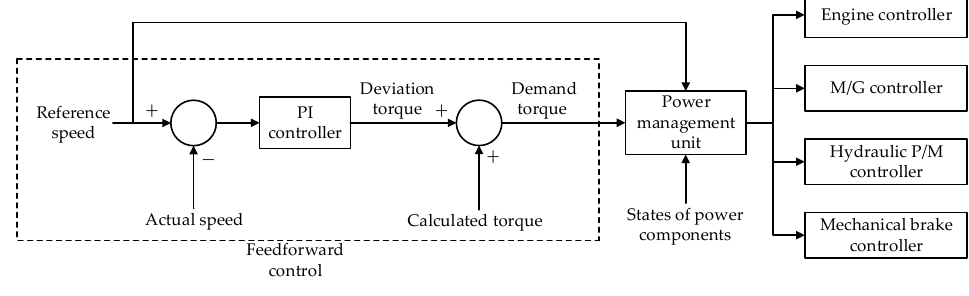
Figure 8. Control flow chart of the HESV.